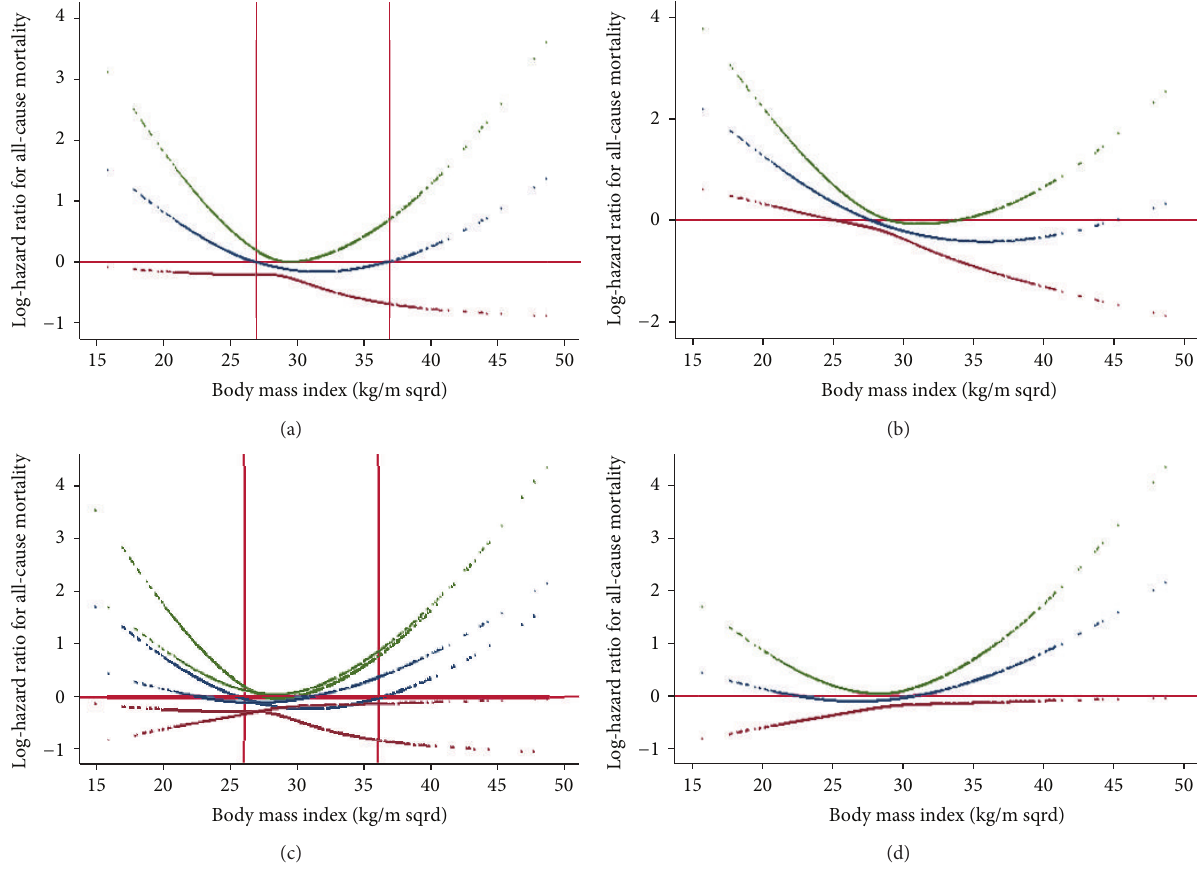
Figure 2: (a) Nonlinear contribution of body mass index to all-cause mortality. (b) Nonlinear contribution of body mass index to all- cause mortality, allowing for waist circumference. (c) Nonlinear contribution of body mass index to all-cause mortality, allowing for hip circumference. (d) Nonlinear contribution of body mass index to all-cause mortality, allowing for both waist and hip circumference.